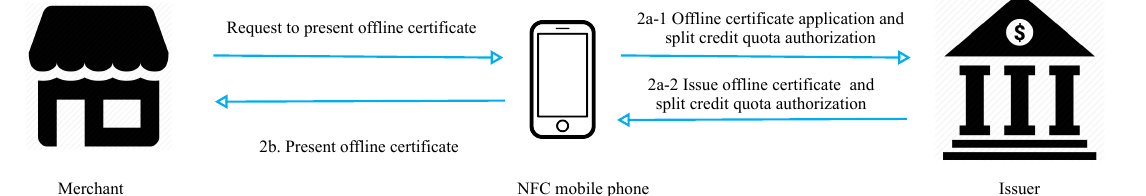
Figure 4. Offline certificate application and split credit line authorization